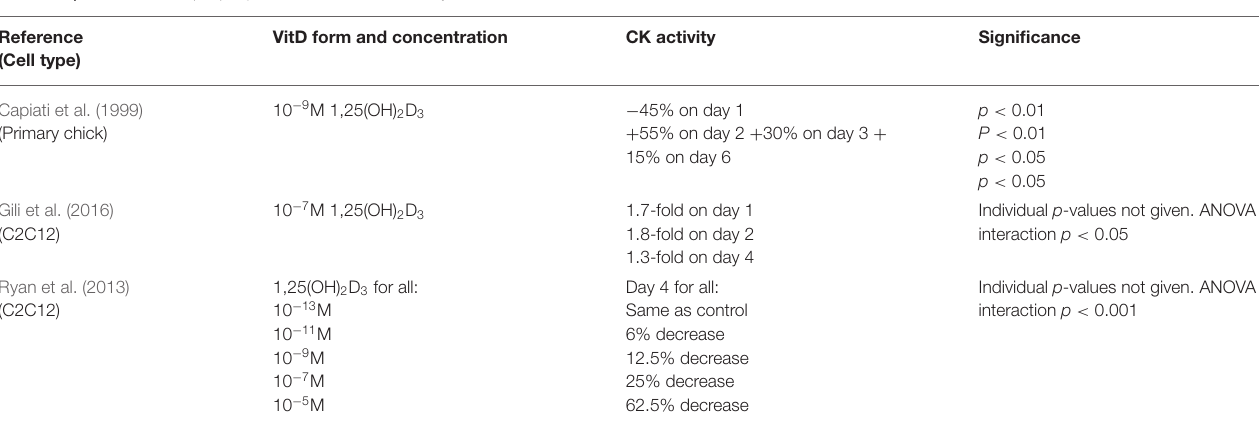
TABLE 4 | Effects of 1,25(OH) 2 D 3 on creatine kinase